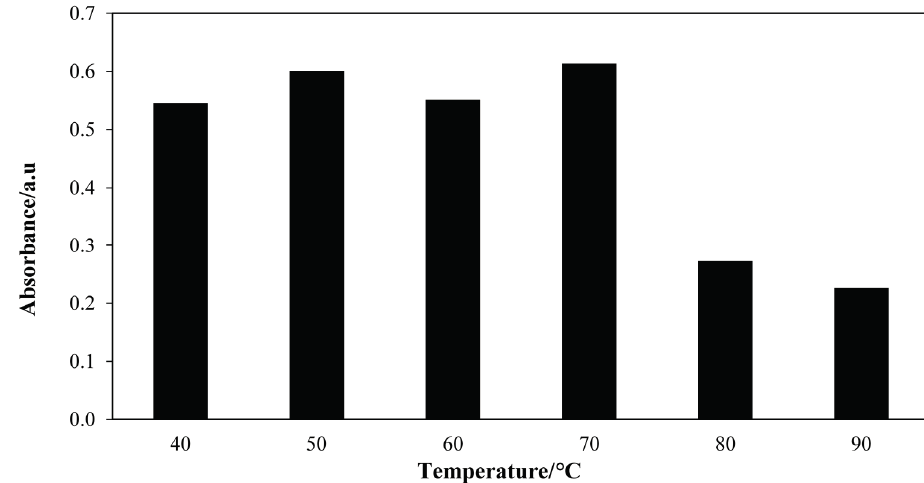
Figure 3. Absorbance maxima for aminolysis reactions at different reaction temperatures. Reaction conditions: Crude palm oil, 6 mmol; hydroxylamine hydrochloride, 3 mmol; CAL-A